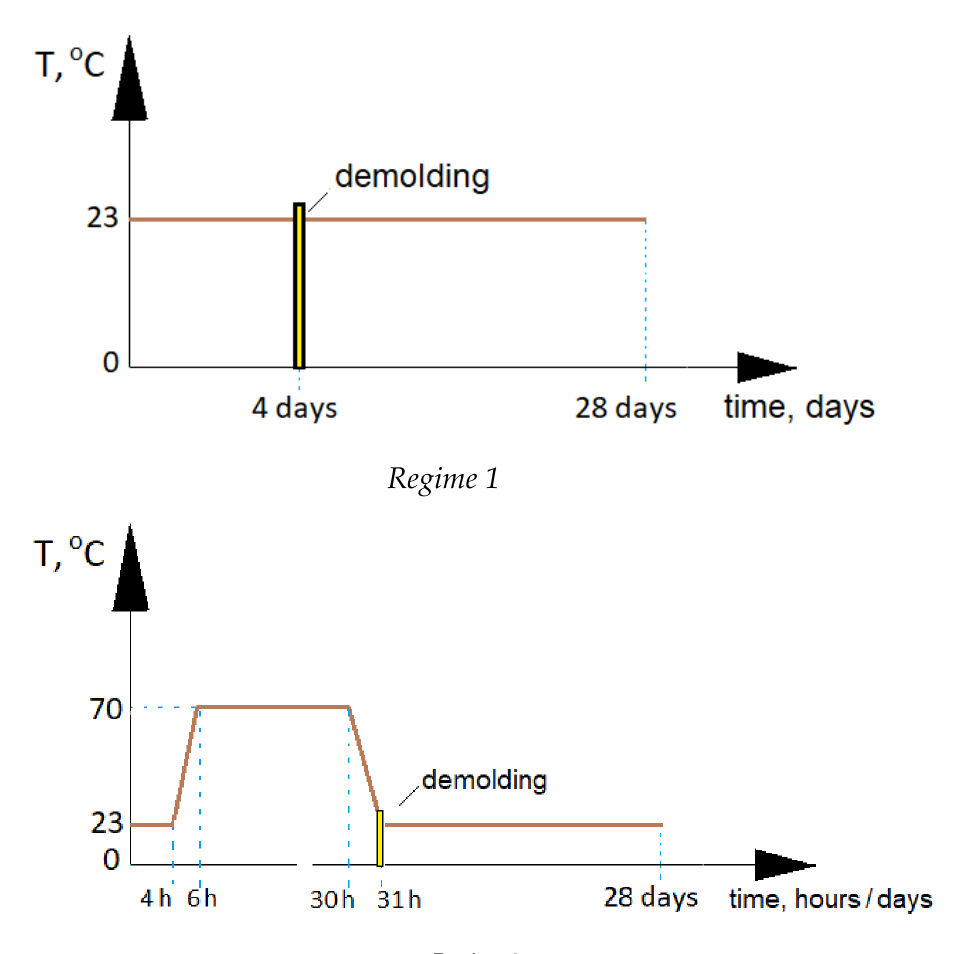
Figure 7. Scheme of the curing regimes. Regime 1 : Curing in ambient conditions with relative humidity (RH) ≈ 42% and temperature 23 ± 3 ◦ C for 4 days → demolding and further curing in ambient conditions until testing at the ages of 4, 7, and 28 days were performed. Regime 2 : Curing in ambient conditions with RH ≈ 42% and temperature 23 ± 3 ◦